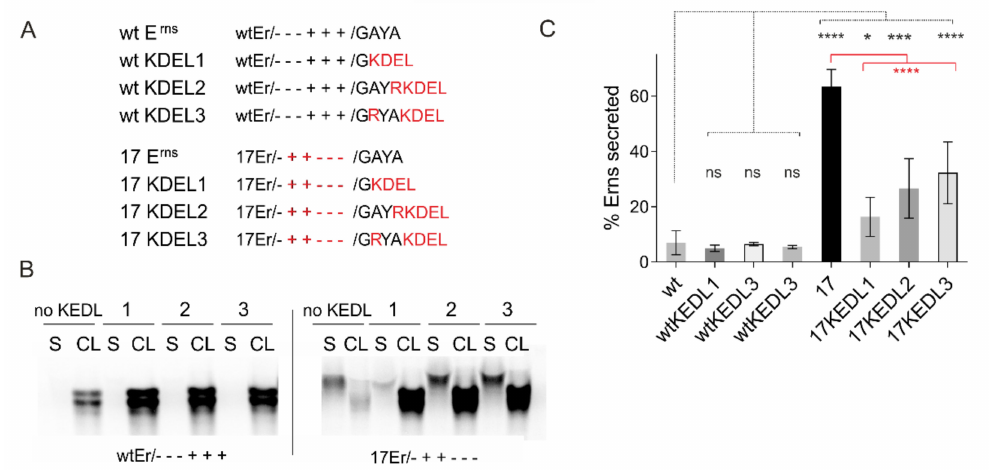
Figure 8. Effect of a KDEL retrieval signal on the secretion of E rns and a mutant thereof. ( A ) Repre- sentation of the basic features of the constructs used in the experiments. The upper panel shows the constructs based on the wt sequence of E rns whereas the lower panel lists the constructs based on mutant 17Er (see also legend to Figure 3 and [80] for further information on the mutant). On the left the names of the constructs are given whereas on the right the charge distribution in the amphipathic helix and the carboxy-terminal sequences of the encoded E rns proteins specifying the type of the KDEL modification are shown. Changes with regard to the wt sequence are in red. ( B ) Result of an immunoprecipitation experiment of transiently expressed proteins using E rns -specific monoclonal antibody 24/16 and separation of precipitates by SDS-PAGE. Proteins were precipitated either from supernatant (S) or from equivalent amounts of lysate of the transfected cells (CL). On top of the gels the expressed constructs are specified. Left part: constructs based on the wt construct SE rns [19]; right part: constructs based on mutant 17Er. Please note that the secreted proteins exhibit a significantly higher molecular weight due to maturation of carbohydrates in the Golgi apparatus. ( C ) Diagram summarizing the results of three independent experiments quantified via phosphorimager analysis. The names of the constructs are given at the X-axis. The bars represent the amount of secreted protein as percent of total recovered E rns . The counts determined for extra- and intracellular E rns were set to 100% expression product as basis for calculation of the secretion value. Error bars are indicated as well as the p -Value of E rns mutants compared to E rns wt without KDEL (black lines and asterisks) and of the mutants containing KDEL compared to mutant 17Er without KDEL (red lines and asterisks) with **** representing p < 0.0001, * p = 0.0109, *** p = 0.0002 and ns = not